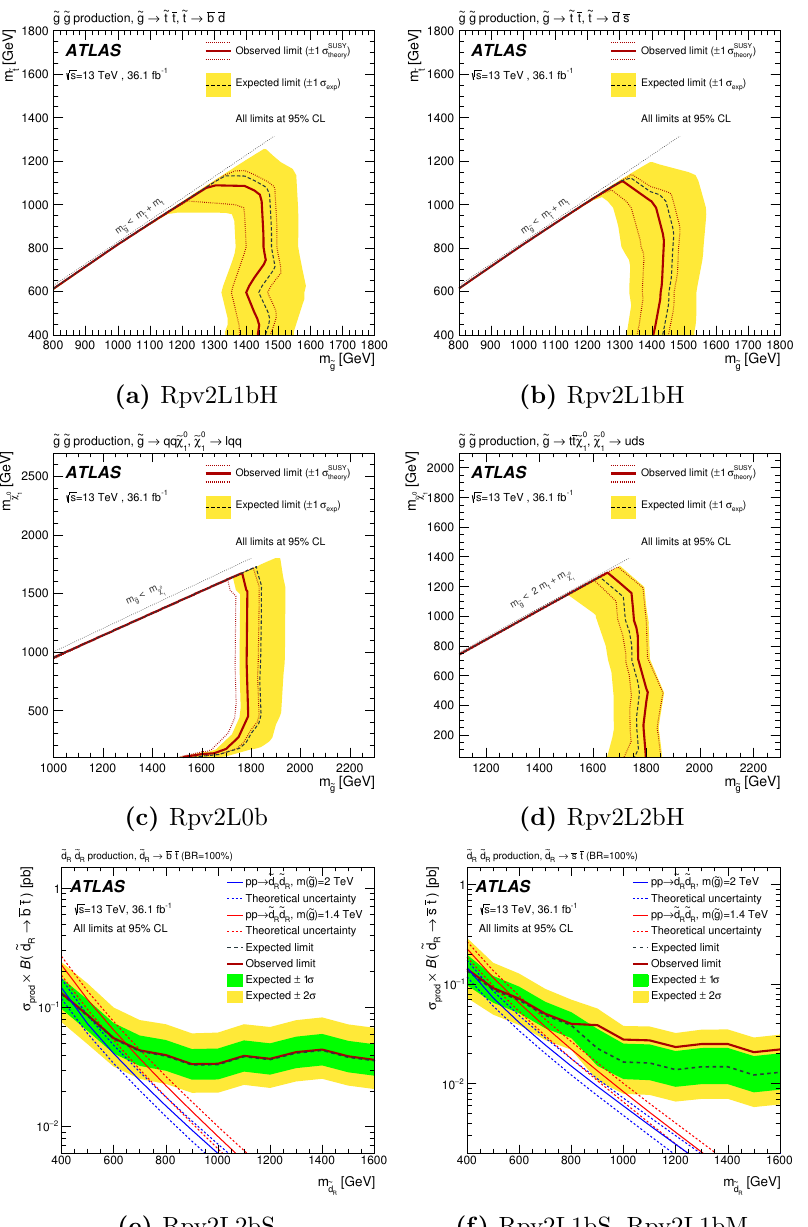
Figure 5. Observed and expected exclusion limits on the ~ g , ~ t , ~ d R and ~ (cid:31) 0 1 masses in the context 1 of RPV SUSY scenarios with simpli(cid:12)ed mass spectra featuring ~ g ~ g or ~ d R ~ d R pair production with exclusive decay modes. The signal regions used to obtain the limits are speci(cid:12)ed in the subtitle of each scenario. All limits are computed at 95% CL. The dotted lines around the observed limit illustrate the change in the observed limit as the nominal signal cross-section is scaled up and down by the theoretical uncertainty. The contours of the band around the expected limit are the (cid:6) 1 (cid:27) results, including all uncertainties except theoretical uncertainties in the signal cross-section ( (cid:6) 2 (cid:27)